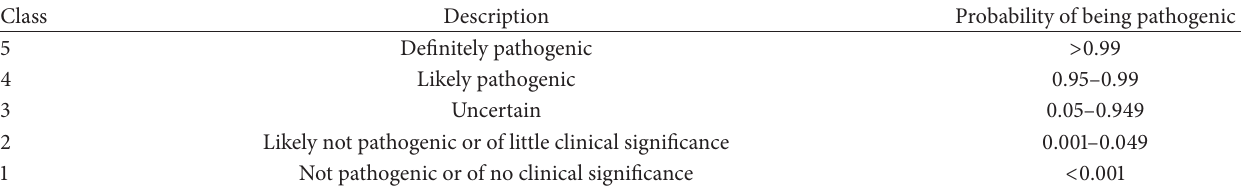
Table 2: Proposed classification system for MMR variant interpretation (Colon Cancer Family Registry 2009, InSiGHT Variant Interpretation Committee 2011)